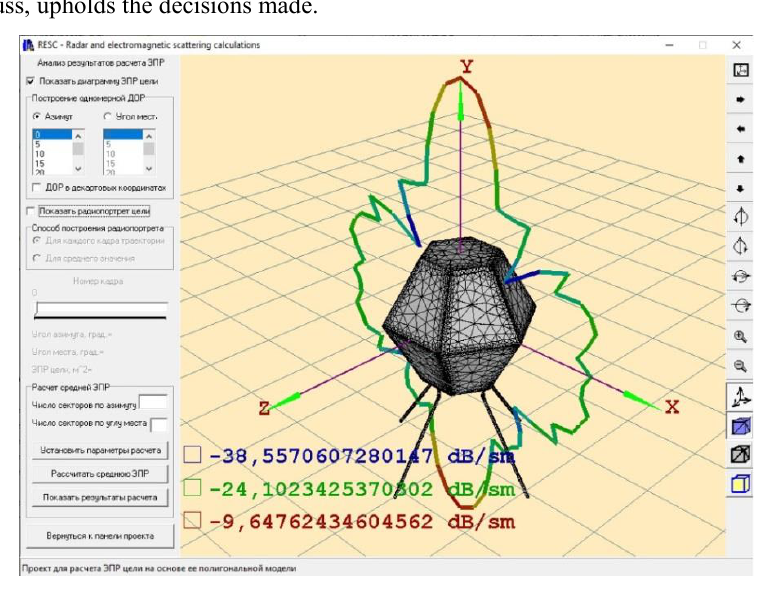
Fig. 4. The working window of the input signal modeling